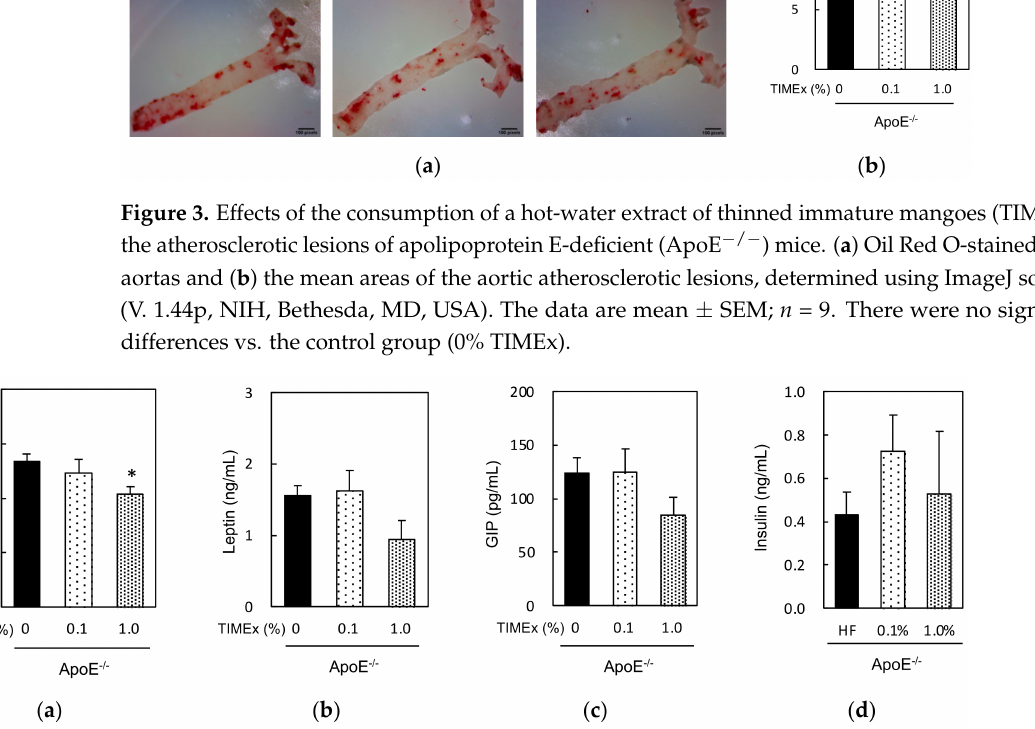
Figure 4. Effects of the consumption of a hot-water extract of thinned immature mangoes (TIMEx) on the serum concentrations of hormones in apolipoprotein E-deficient (ApoE − / − ) mice. ApoE − / − mice were divided into three diet groups: an AIN-93M-based 20% fat diet containing 0%, 0.1%, or 1.0% TIMEx. Following 8-weeks consumption, mice were sacrificed without fasting. The data are mean ± SEM; n = 9. ( a ) Resistin, ( b ) leptin, and ( c ) glucose-dependent insulinotropic polypeptide (GIP), ( d ) Insulin. * p < 0.05 vs. the control group (0% TIMEx); Williams’s multiple comparison